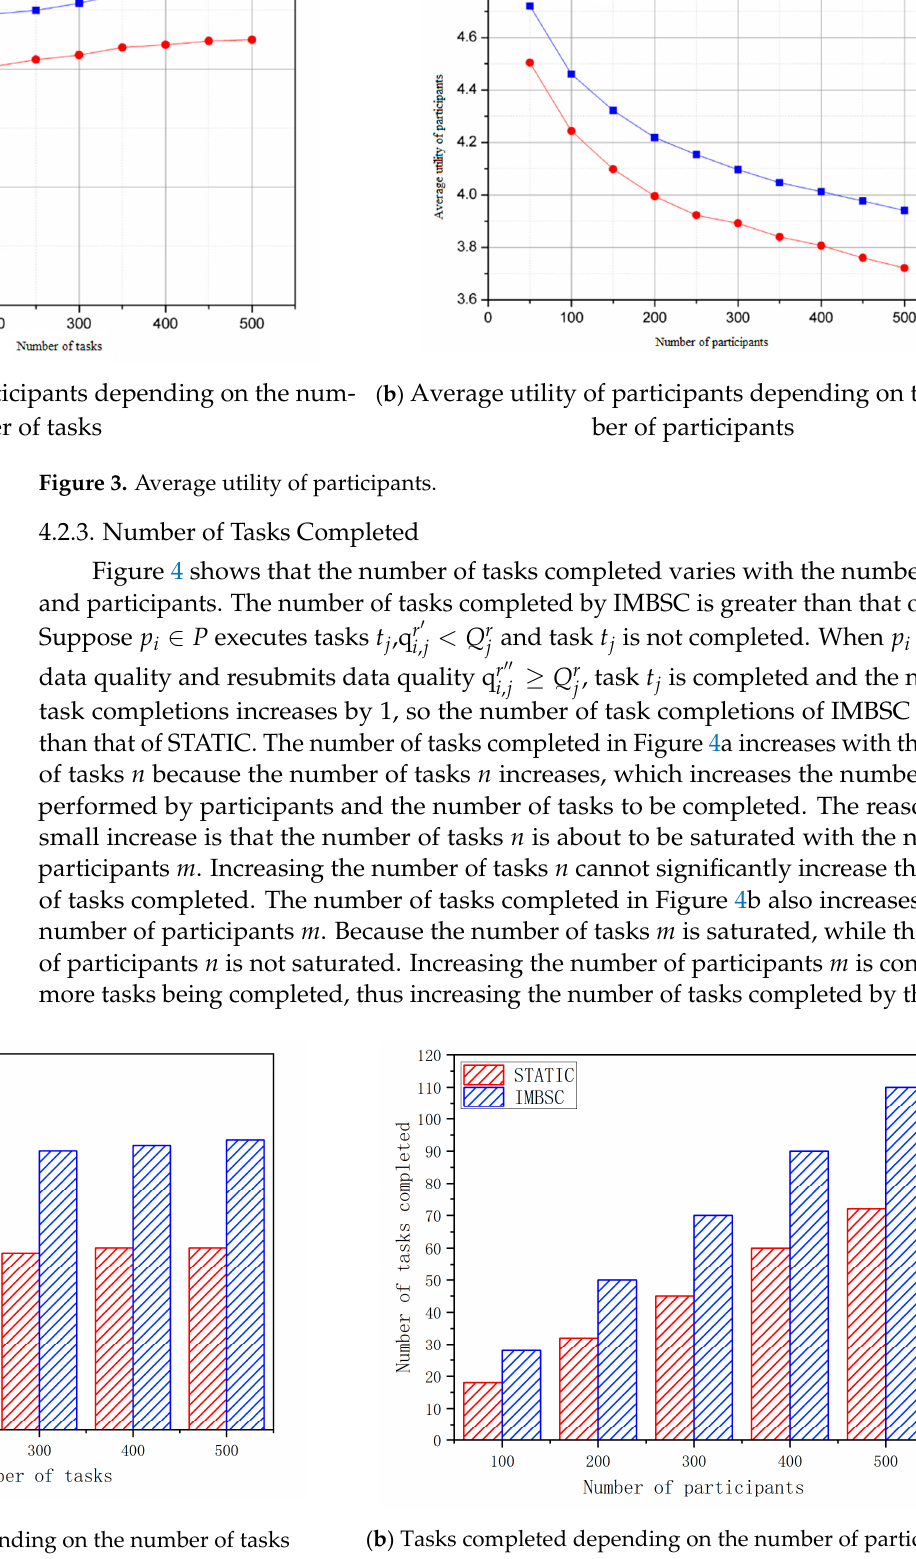
Figure 4. Number of tasks completed.